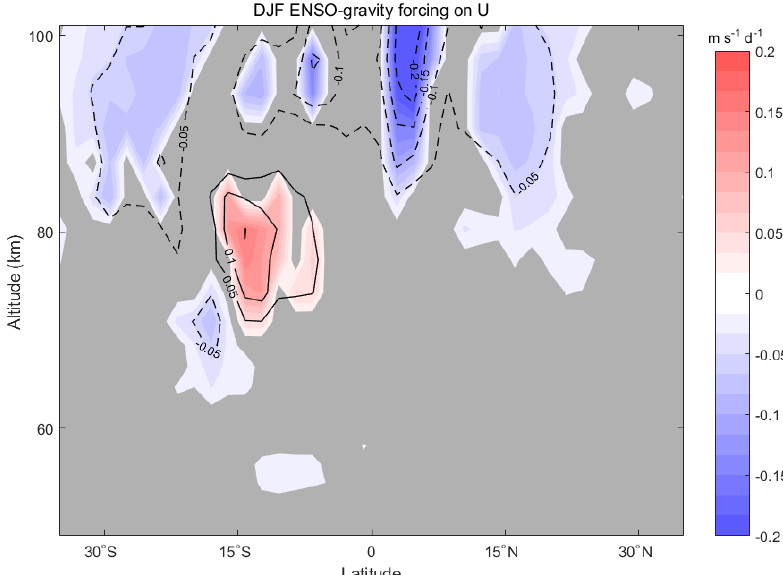
Figure 9. The linear regression coefficient of normalized Niño3.4 in the GW forcing on the amplitude of DW1-U during the 1979–2013 winters (DJF). Solid lines and red shadings denote the positive responses, while dashed lines and blue shadings denote the negative responses; the grey regions indicate where the response is insignificant at the 95% level according to the F